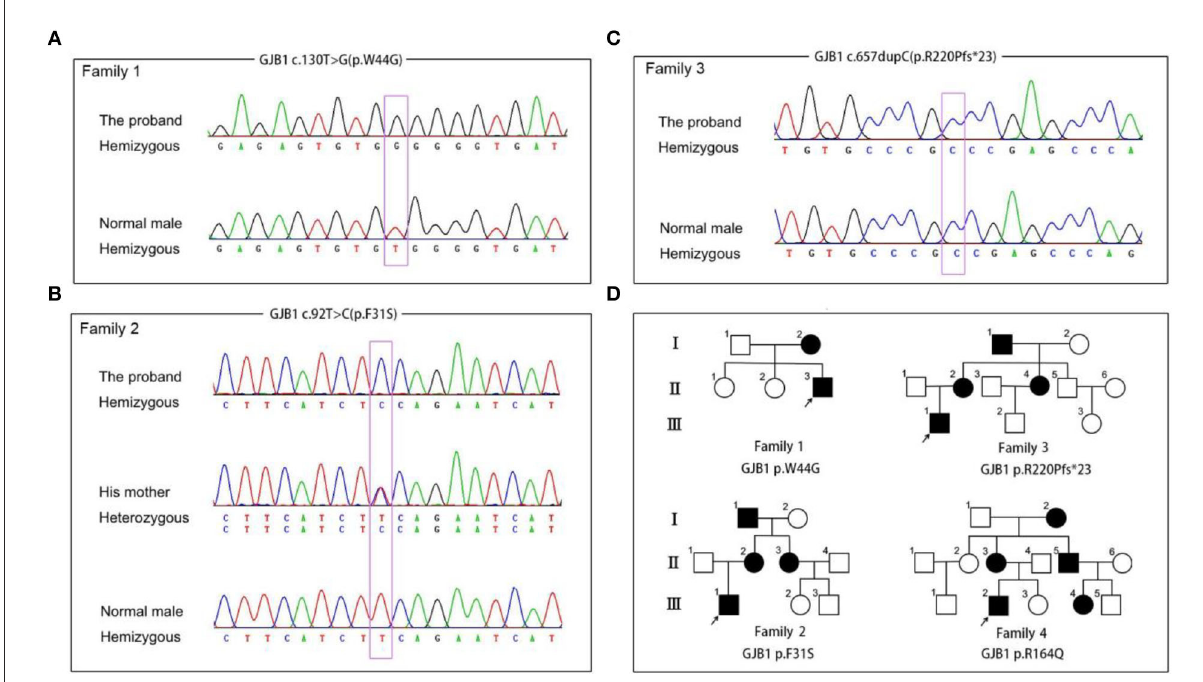
FIGURE1 Segregation of GJB1 mutations. (A) Sequence chromatogram of the c.130T > G (p.W44G) missense mutation in family 1. (B) Sequence chromatogram of the c.92T > C (p.F31S) missense mutation in family 2. (C) Sequence chromatogram of the c.657dupC (p.R220pfs*23) frameshift mutation in family 3. (D) Pedigrees of families with GJB1 mutations in the study. Corresponding mutation sites are highlighted in purple boxes.